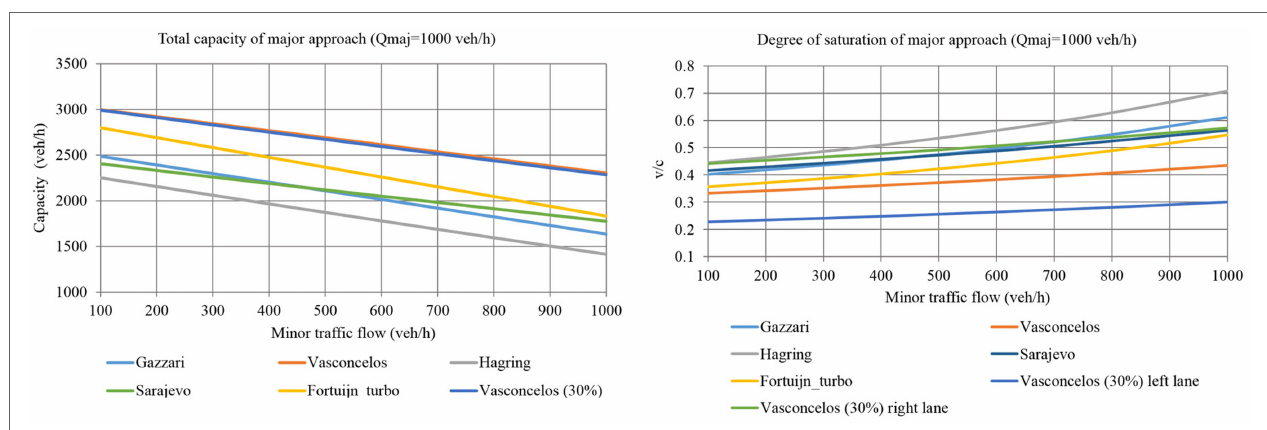
FIGURE 5 | Capacity and v / c curves for scenario A 5